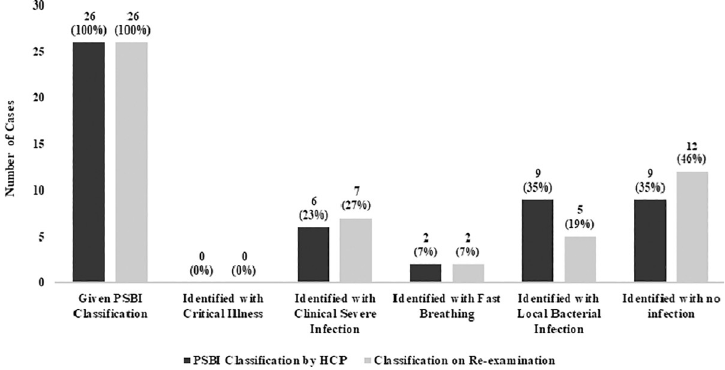
Fig 2. Identification of PSBI in infants aged 0–59 days by the HCP and on re-examination by surveyor (n = 26).